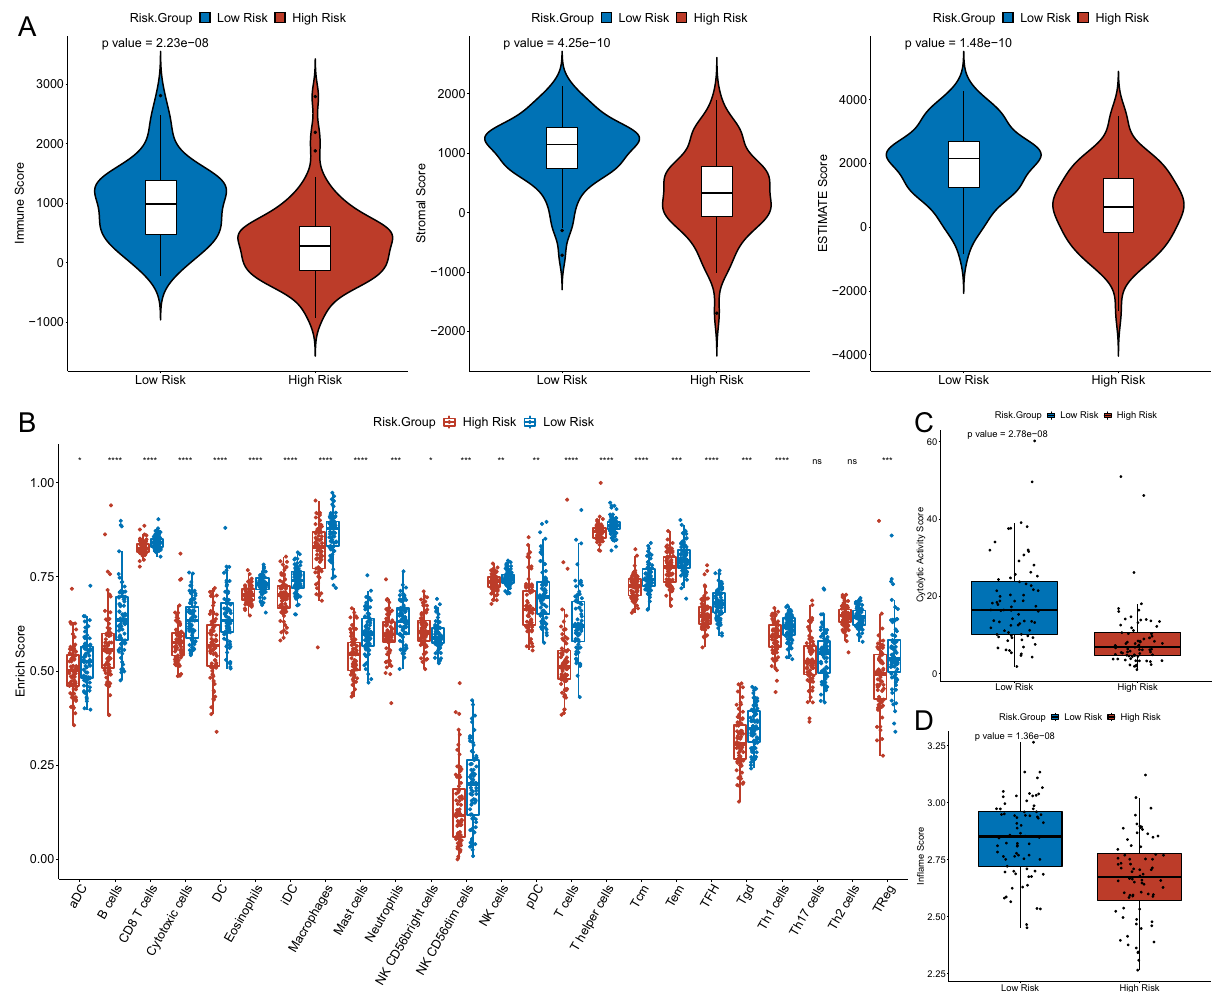
Figure 6. Biological differences between the high- and low-risk groups. ( A ) The violin plot showed the difference in Immune Score (left), Stromal Score (middle), and ESTIMATE Score (right) between high- and low-risk groups. ( B ) Comparison of the enrichment scores of 24 types of immune cells between low- (green box ) and high-risk (red box ) groups in the TCGA cohort. ( C ) Boxplots show the distribution of CYT score (top) and Inflame score (bottom ) in the low-risk group versus the high-risk